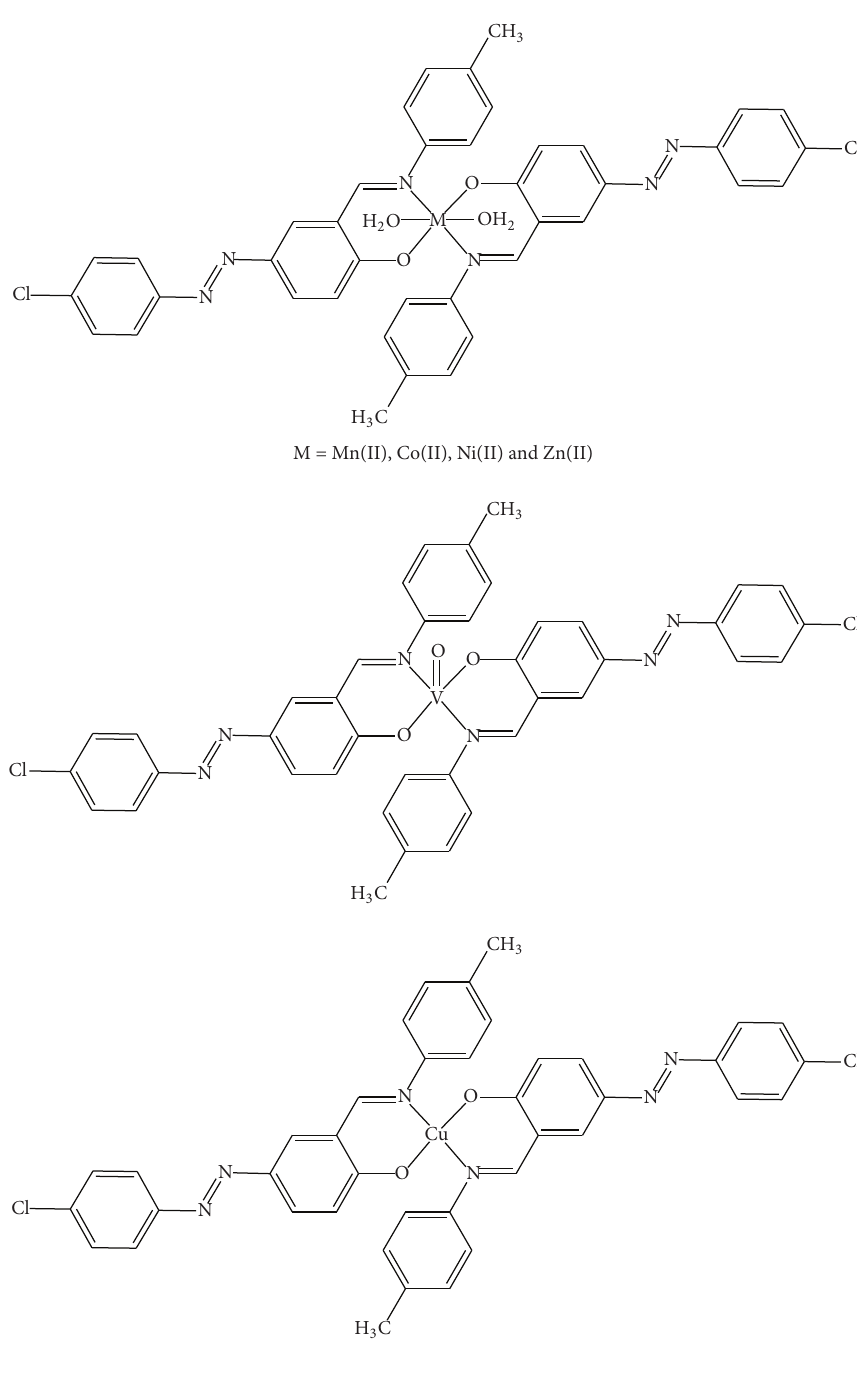
S 2: Geometry of the metal(II)